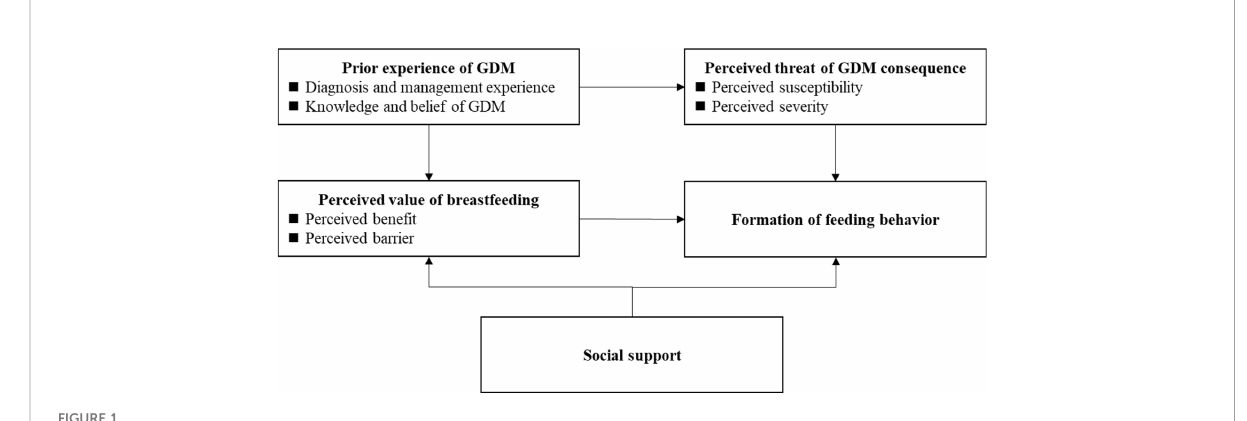
FIGURE 1 Framework of interview guideline based on